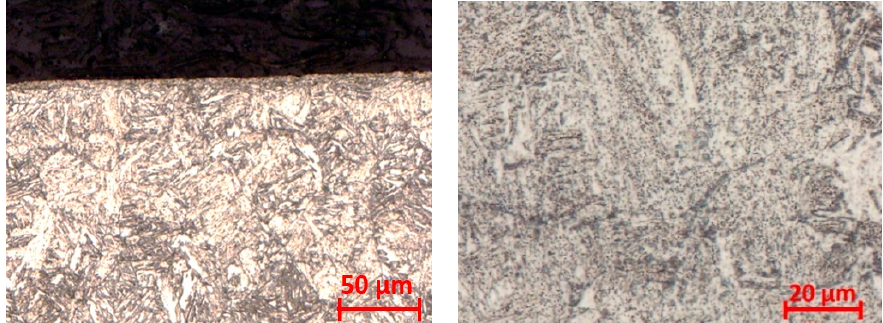
Figure 9. Sample without surface treatment, observation on the edge of the cylinder—magnified 100× ( left ); detail—magnified 500× ( right ).